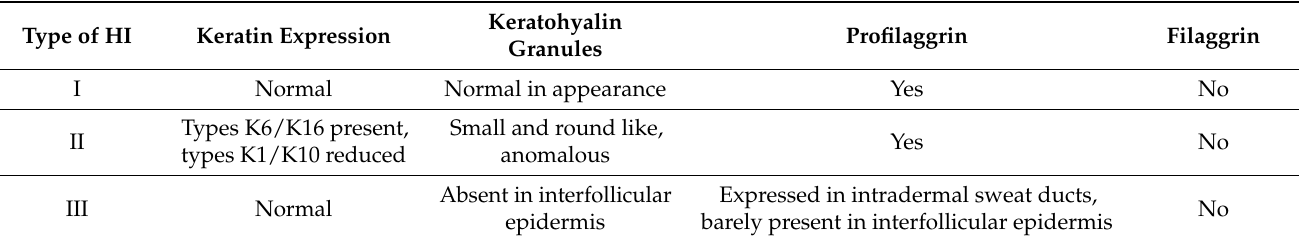
Table 1. Main types of Harlequin